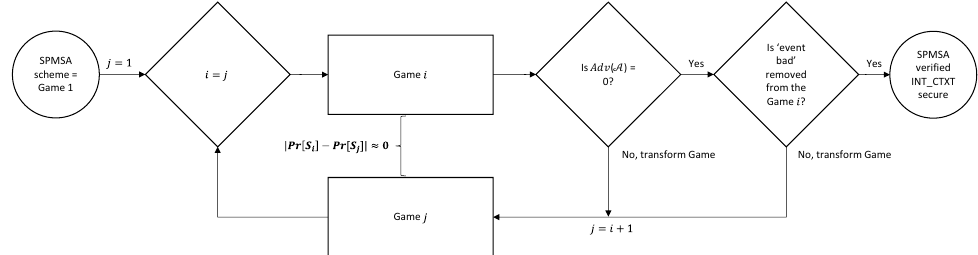
Figure 12. Game-Hopping to Verify INT_CTXT Property of Platoon Key Update Phases.